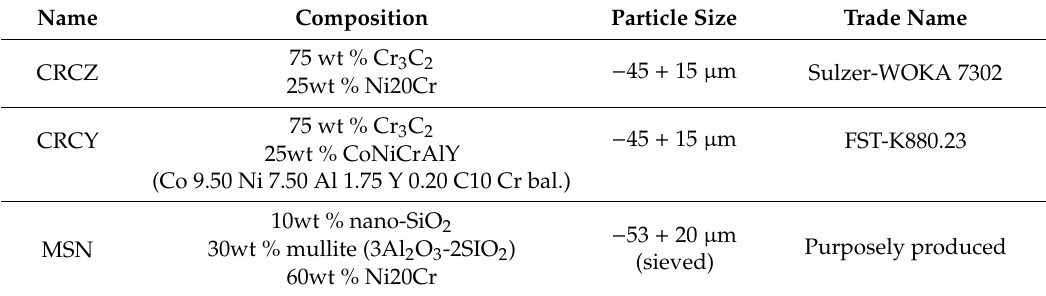
Table 1. Designation and composition of powders used in the experimental